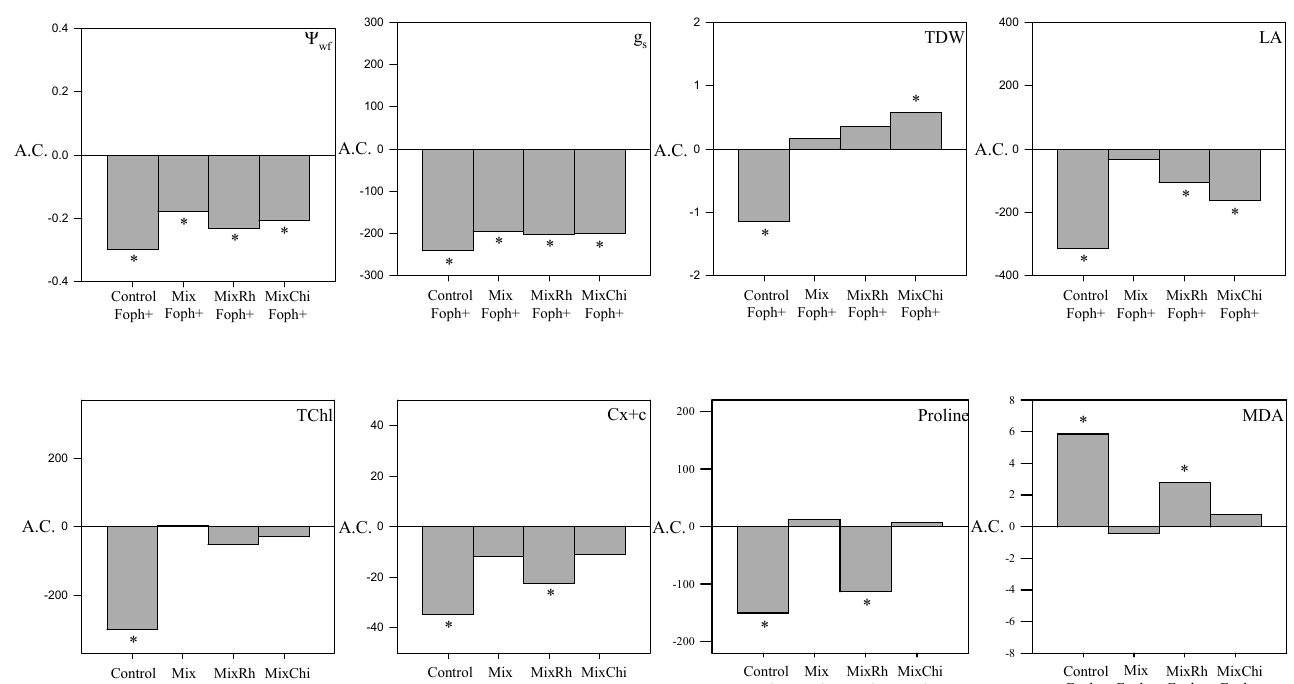
Figure 7. Comparative effect of the variables evaluated in cape goose berry plants inoculated and treated with mixtures of biological control agents and organic additives (Mix ( T. virens + B. velezensis ), MixRh ( T. virens + B. velezensis + burnt rice husk), and MixChi ( T. virens + B. velezensis + chitosan) in relation to the behavior of absolute control plants (Foph) 50 days after inoculation. A.C. indicates the average value of absolute control plants for each of the parameters. * indicates the statistical differences in the treatment compared to control plants (Foph).